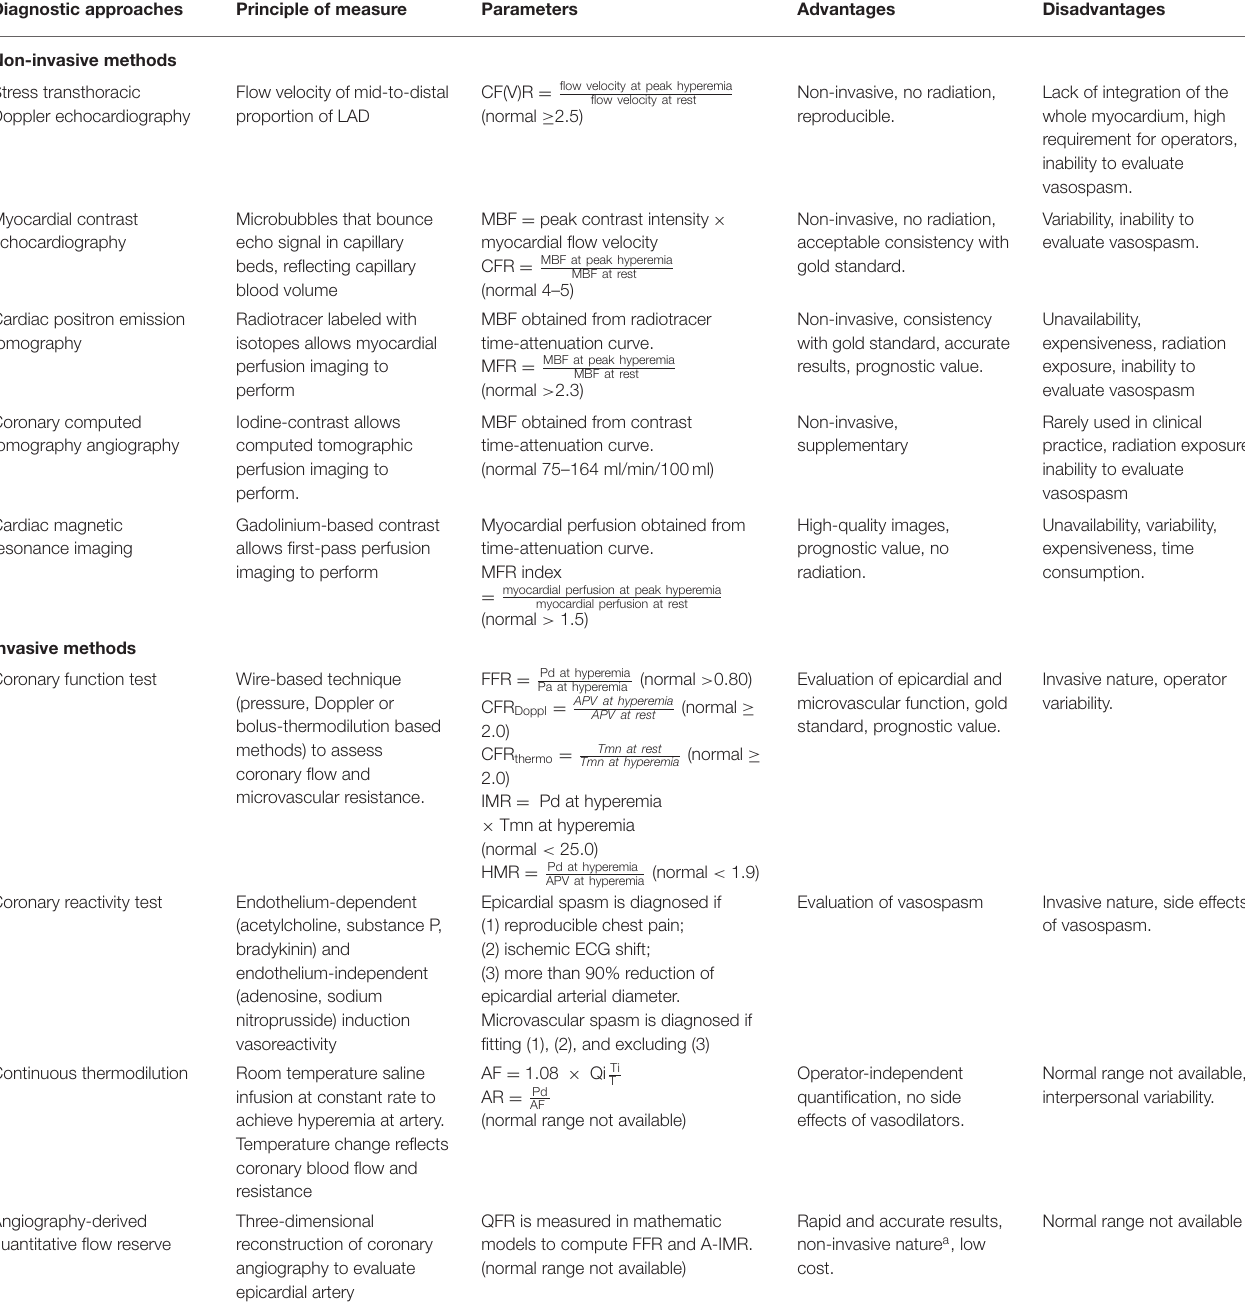
TABLE 1 | Summary of diagnostic approaches of